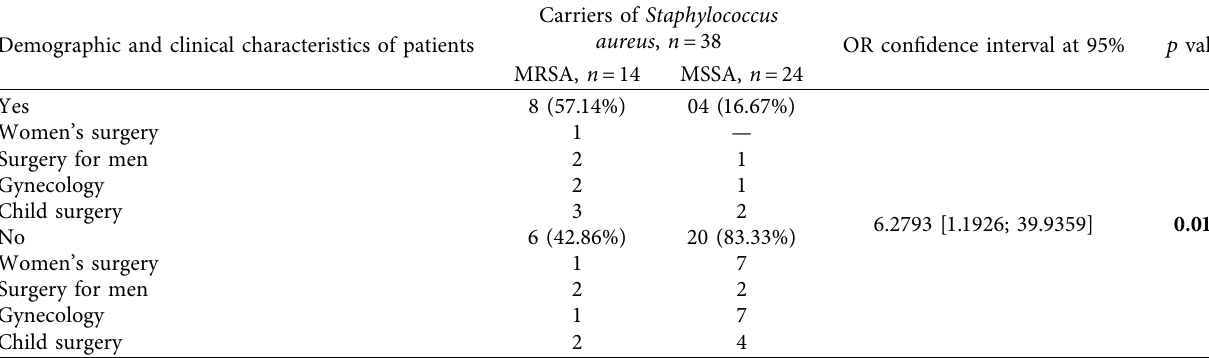
Table 3: Antibiotic resistance profile of isolated Staphylococcus aureus strains MRSA and MSSA ( N � 38).